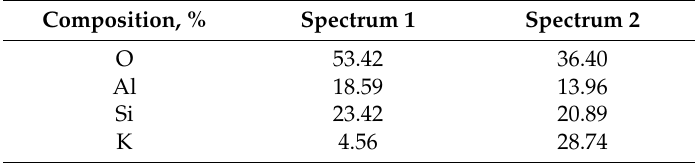
Table 4. Composition of elements measured via EDS as shown in Figure 11.